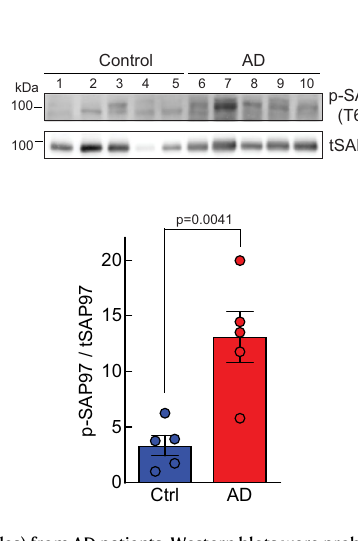
females)fromADpatients.Westernblotswereprobedwithantibodiesspeci fi ctoa known PKC phosphorylation site on SAP97 (Thr656) (Top) or to total SAP97 (Bottom). Graph depicts the quanti fi cation of the data in the western blot. a , b Bands were quanti fi ed using densitometry and the phospho-SAP97 signal was normalized to total SAP97 signal and PKC α signal was normalized to its β -actin loading control. Normalized data from the depicted western blots were plotted (Bottom) as average normalized intensity ± SEM ( p values were determined using unpaired two-tailed Student ’ s t test). Source data and uncropped blots for fi gures a and b are in the Source Data fi